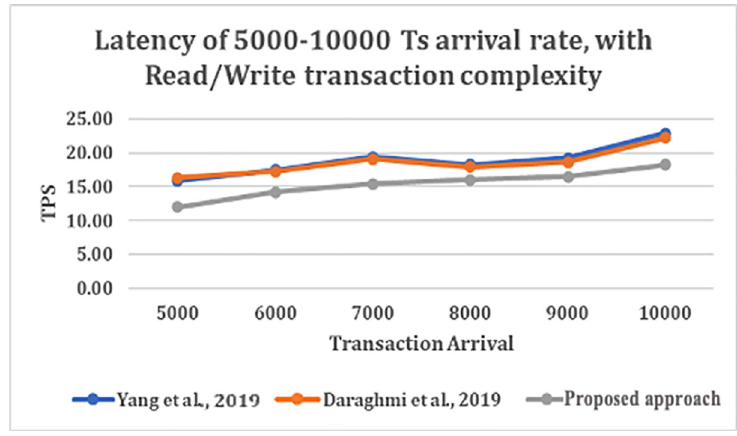
Figure 5. Latency of 5000 – 10000 transaction arrival rate with read/write